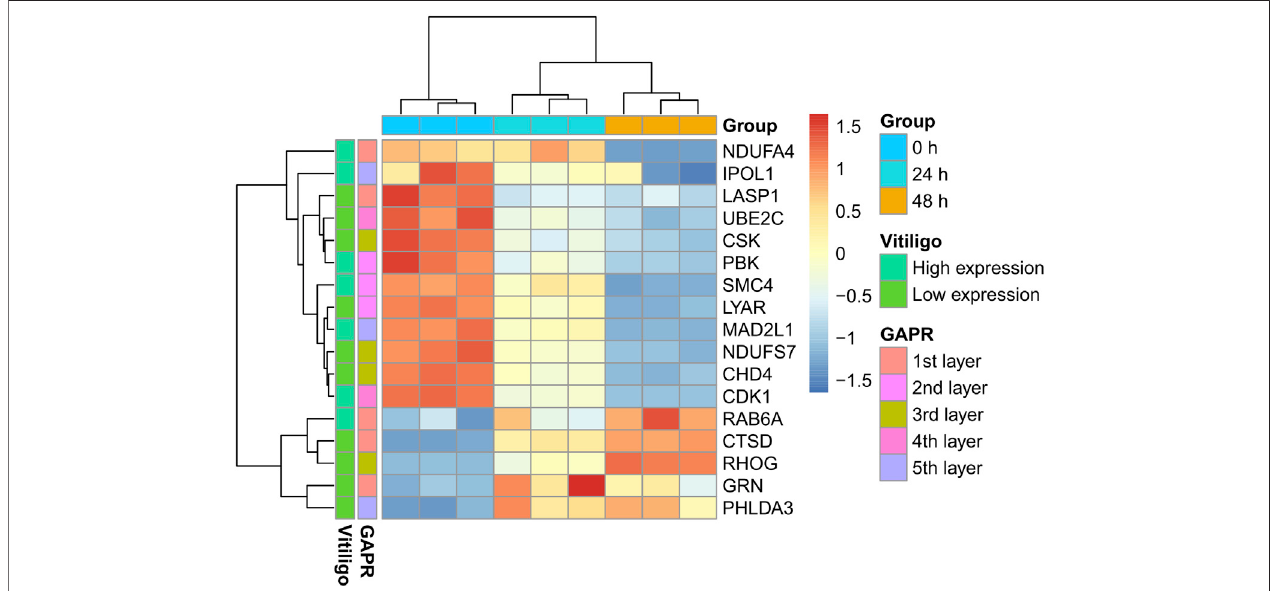
FIGURE 7 | Heatmap of these 17 proteins. These proteins were the intersection of kaempferide-induced DEPs and articulation proteins based on the GAPR method. DEP: differentially expressed protein. GAPR: greedy articulation point removal.